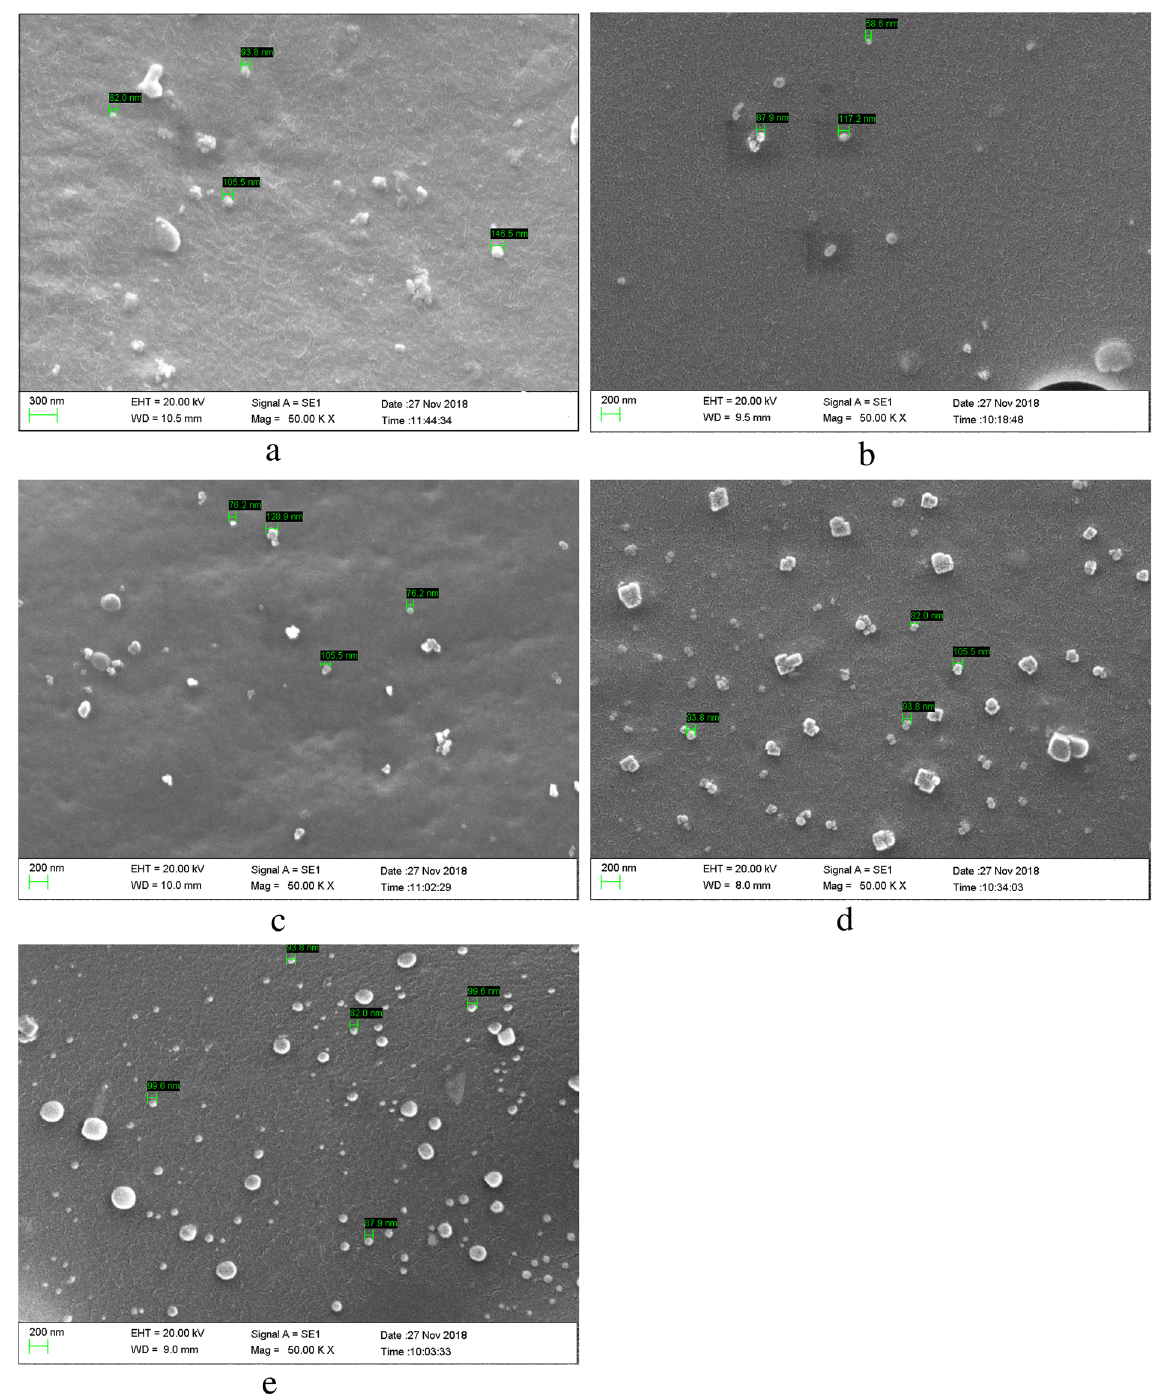
Figure 2. SEM images of the nanocomposite for different weight percentages of Bi 2 O 3 . ( a ) 5 wt%, ( b ) 10 wt%, ( c ) 30 wt%, ( d ) 40 wt%, and ( e ) 50